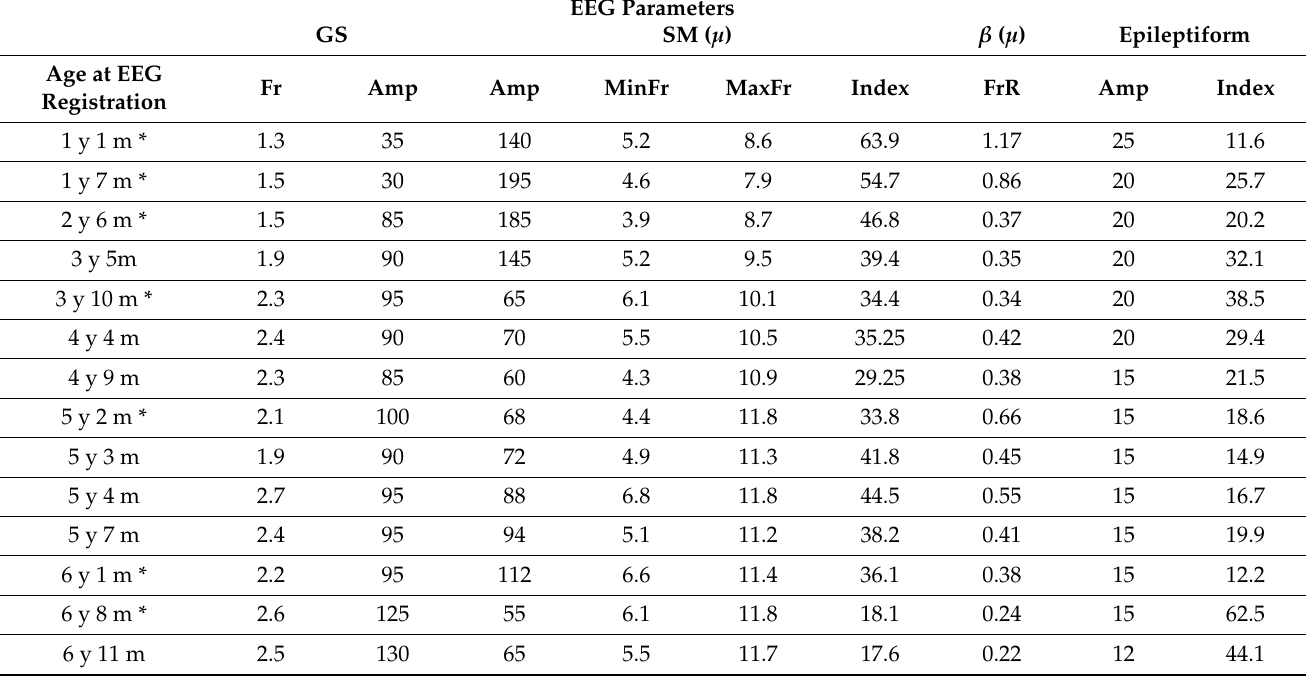
Table 2. EEG data of patient U relevant for 14 EEG recordings for several parameters: